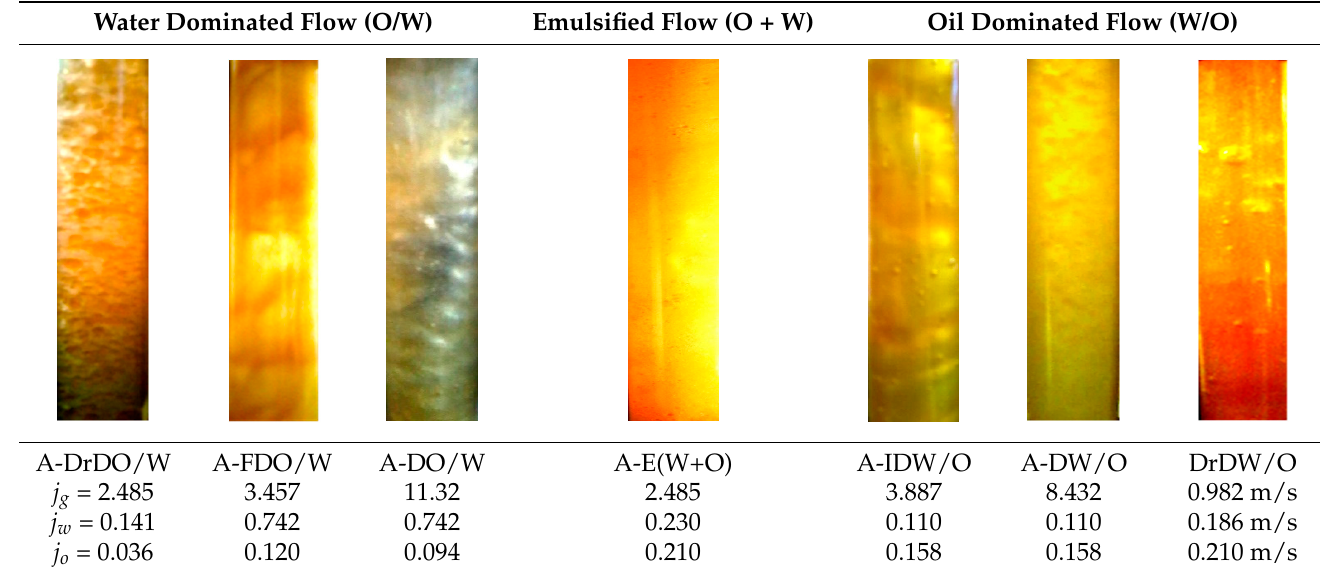
Table 3. Air–water–oil three-phase downflow patterns in vertical pipe for η o = 0.159 Pas.